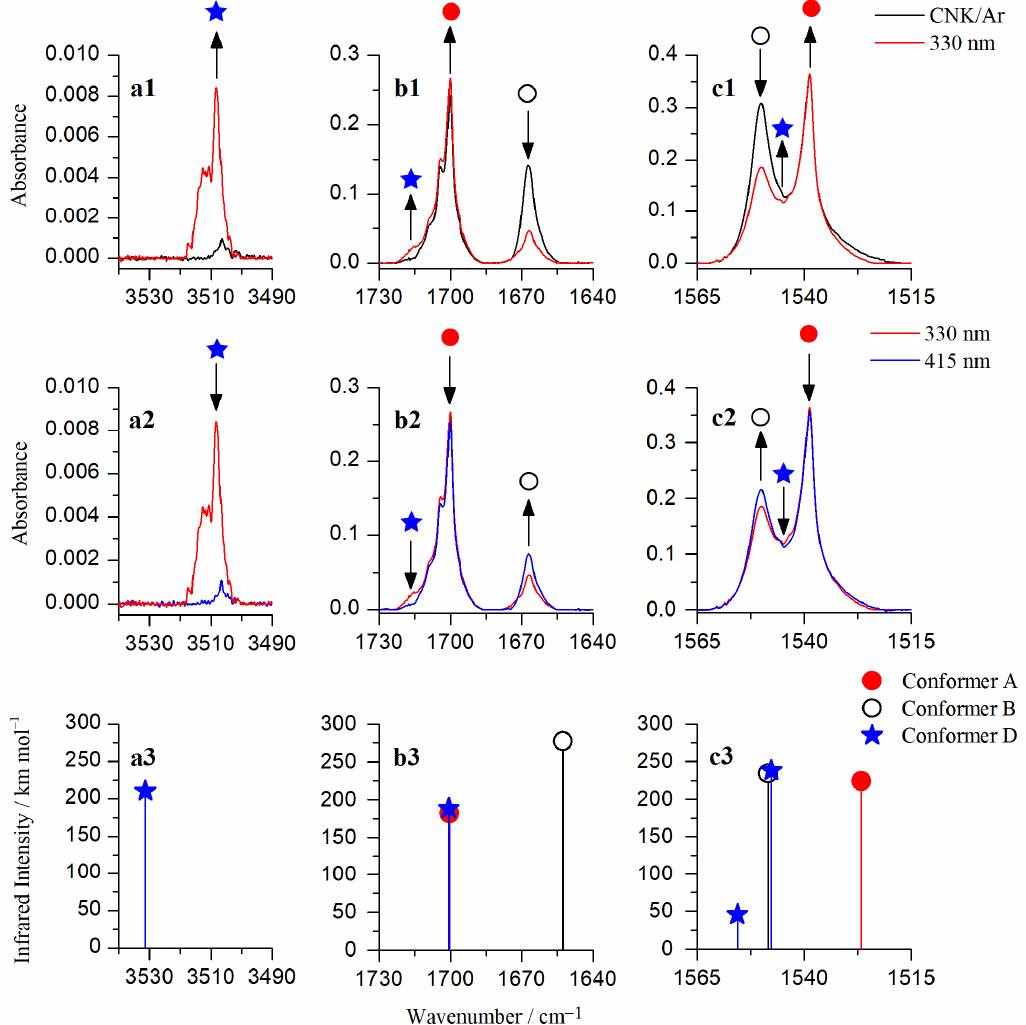
Figure 2. Selected parts of infrared spectra of 5-chloro-3-nitro-2-hydroxyacetophenone isolated in an argon matrix: ( a1 – c1 ) After deposition at 15 K (10 K for measurement) (black spectra); ( a1 – c1 , a2 – c2 ) upon irradiation at 330 nm (red spectra) and at 415 nm (blue spectra), respectively; ( a3 – c3 ) stick spectra, calculated for conformers A , B , and D at the B3LYP/6-311++G(3df,3pd) level of theory.